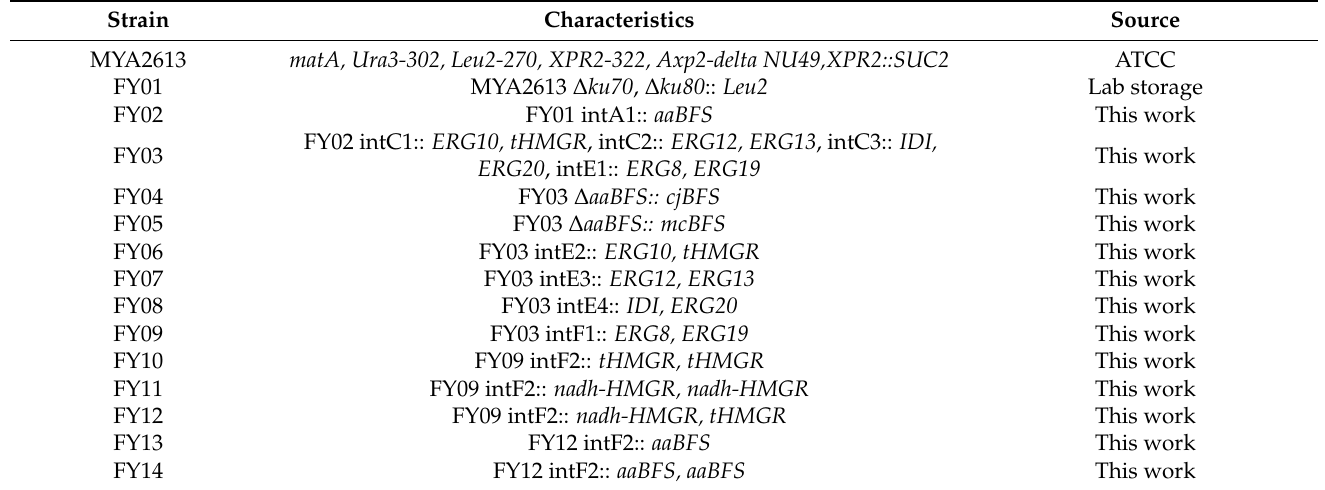
Table 1. Strains used in this